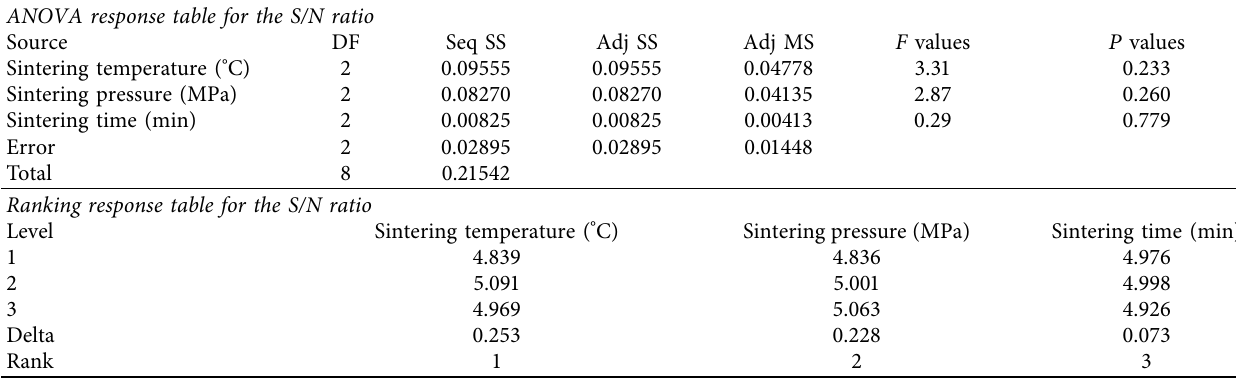
Table 10: ANOVA analysis for the mean S / N ratio of experimental